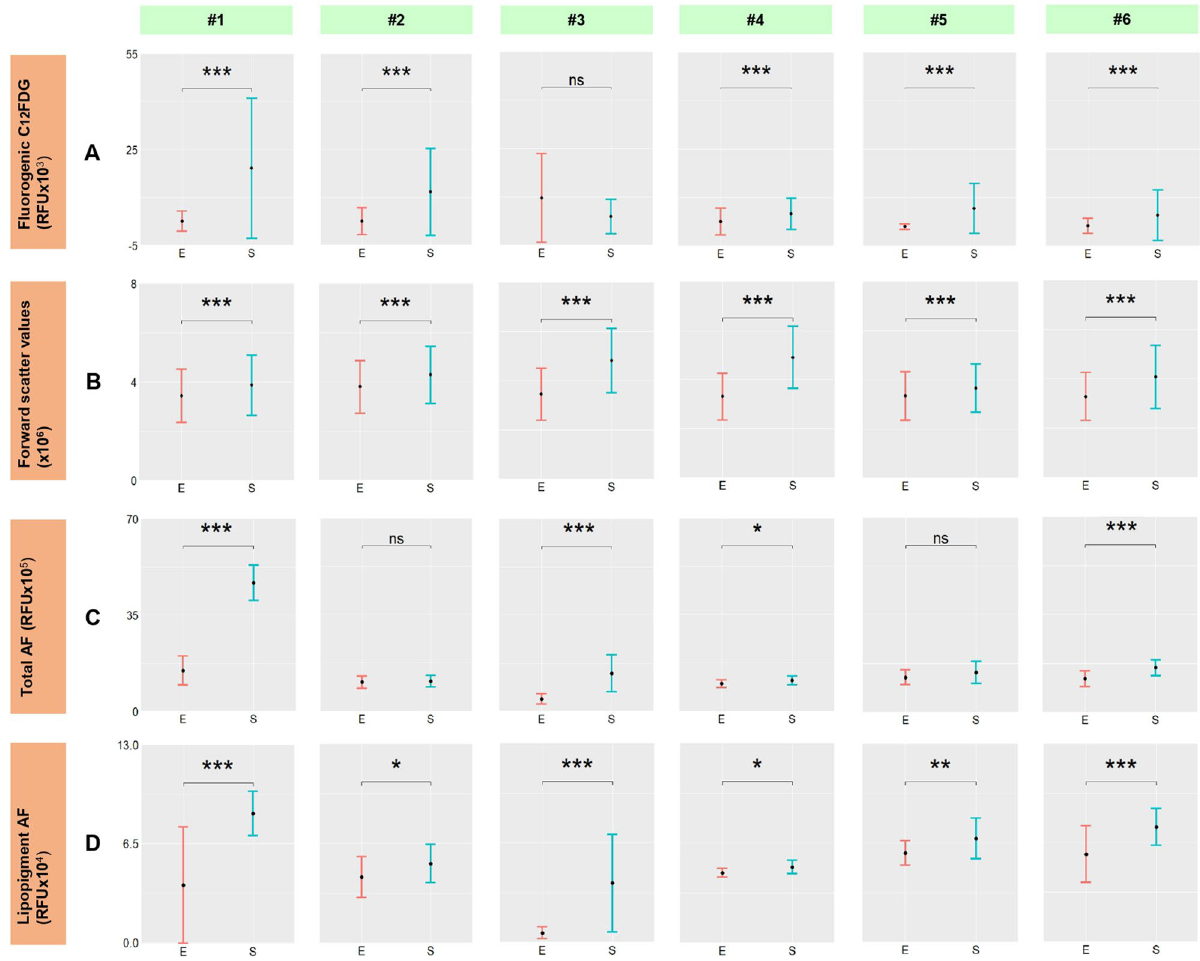
Figure 3. Error bar plots showing comparisons between the early and senescent hMSCs passages for six donors on ( A ) fluorescent-based β -galactosidase staining through C 12 FDG mean ( B ) forward scatter mean ( C ) total autofluorescence mean ( D ) lipopigment autofluorescence mean. Error bar plots were produced based on at least 10 cells measured per sample (experimental repeats n = 10) and 100 cells involved per autofluorescence run, and 10 5 cells per flow cytometry measurement. Statistical analysis: one-tailed unequal variance t-test was performed between early and senescent data. Pairs with significant differences are marked with ***(P ≤ 0.001), **(P ≤ 0.01), *(P ≤ 0.05) and ns indicates no significance (P >